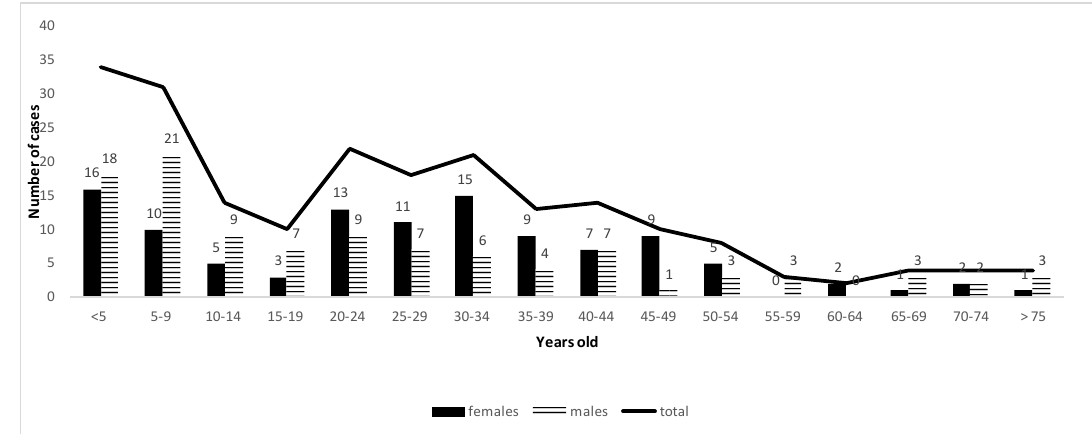
Figure 3. Demography of cryptosporidiosis reported cases from 2017 to 2019 in private laboratories in France.